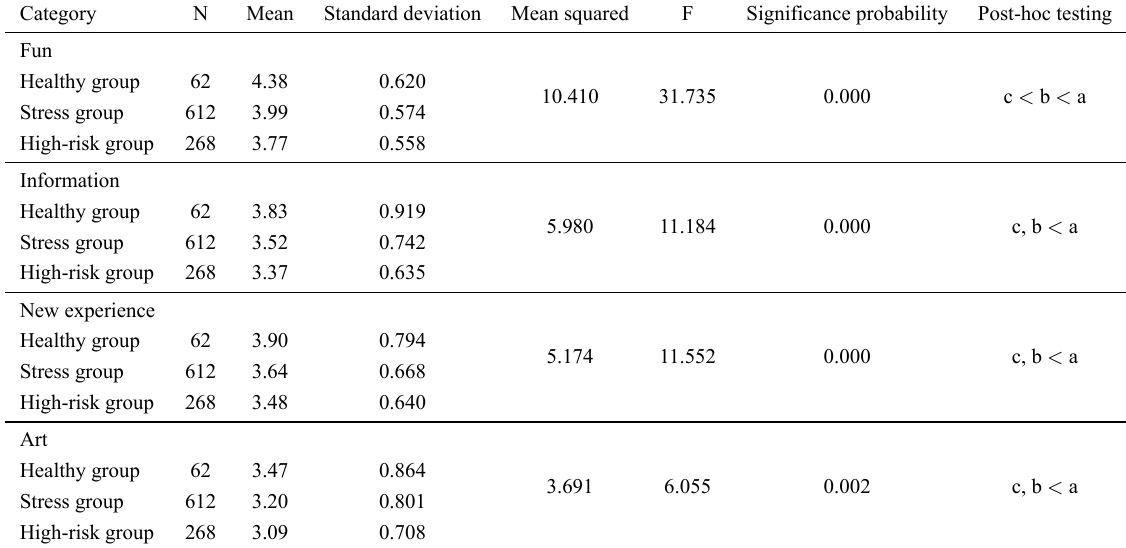
Table 3. Differences in leisure experience according to psychosocial stress (n = 942).